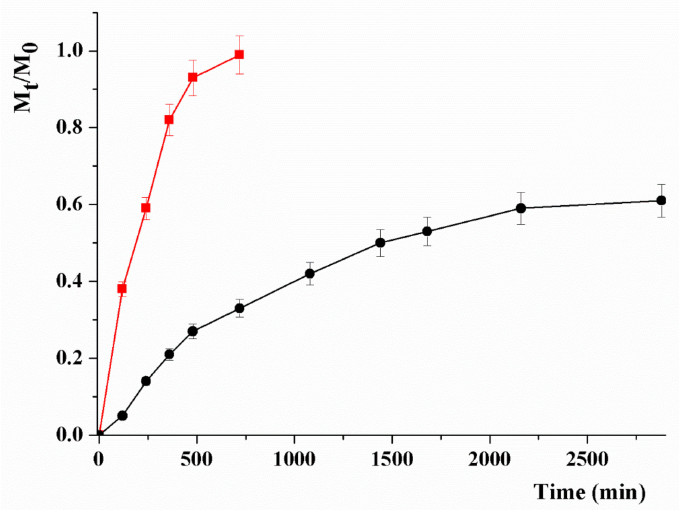
Figure 6. pH-responsive MTX release profile ( M t / M 0 ) from CS_MWCNT at pH 5.0 (red line) and 7.4 (black